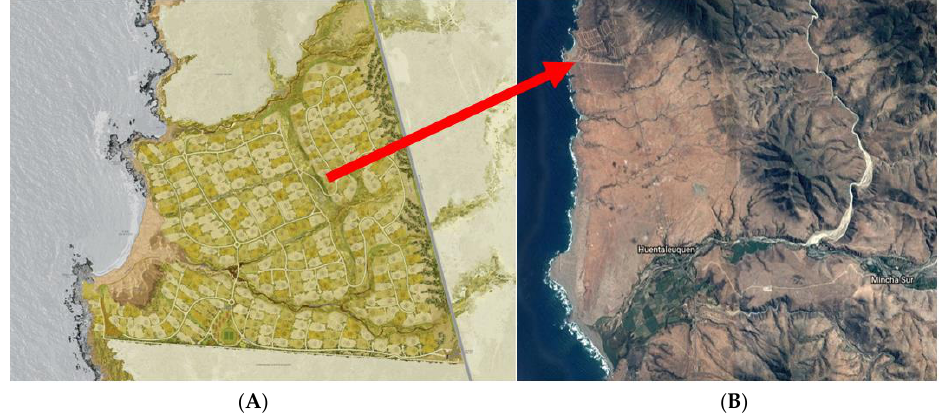
Figure 3. Google map ( B ) of the Huentelauquén area, showing the subdivision of the Fundo Agua Dulce in the northern part of the map, bordering the sea. The map ( A ) shows the subdivision of the property in recreation plots for summer houses.